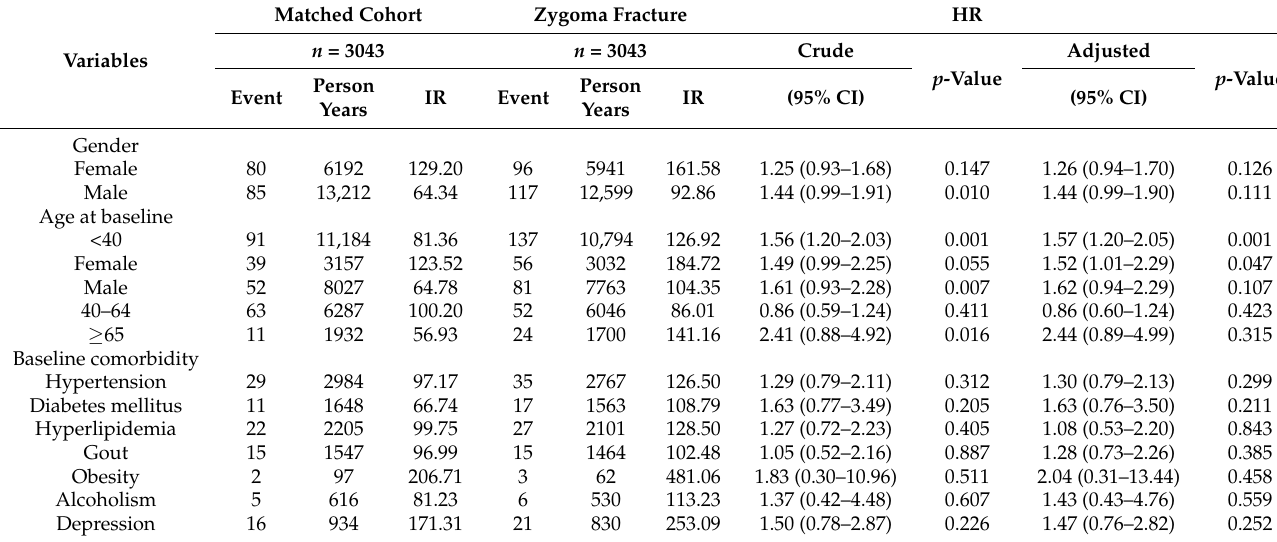
Table 3. Incidence rates, hazard ratio and confidence intervals of post-traumatic headache in different